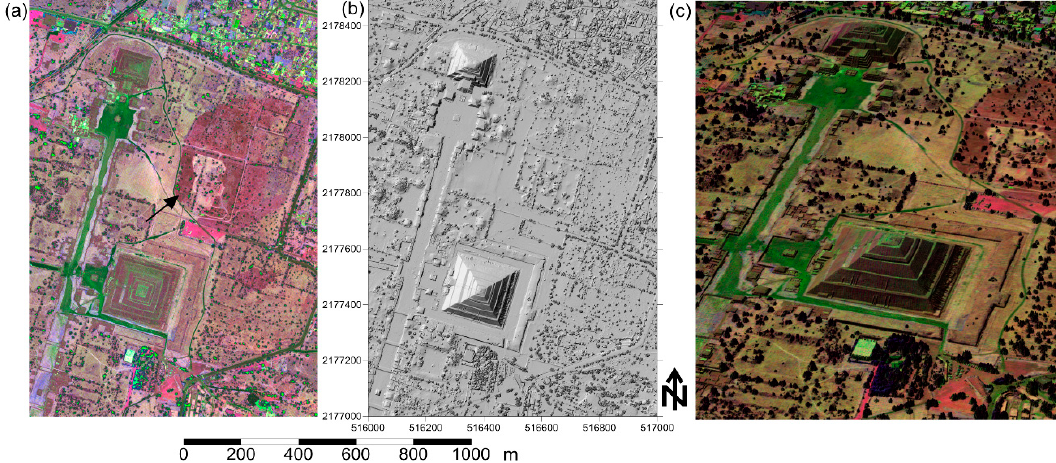
Figure 6. Spectral and spatial data products derived with the Titan sensor of the archaeological site of Teotihuacan in central Mexico. ( a ) False color multispectral lidar intensity image generated by using the 1550 nm intensity for the red channel and the 532 and 1064 nm intensities for the green and blue channels; ( b ) digital surface model (DSM) derived from the lidar spatial data; ( c ) perspective view generated by overlaying the false color multispectral intensity image over a 3D surface model based on the lidar DSM.